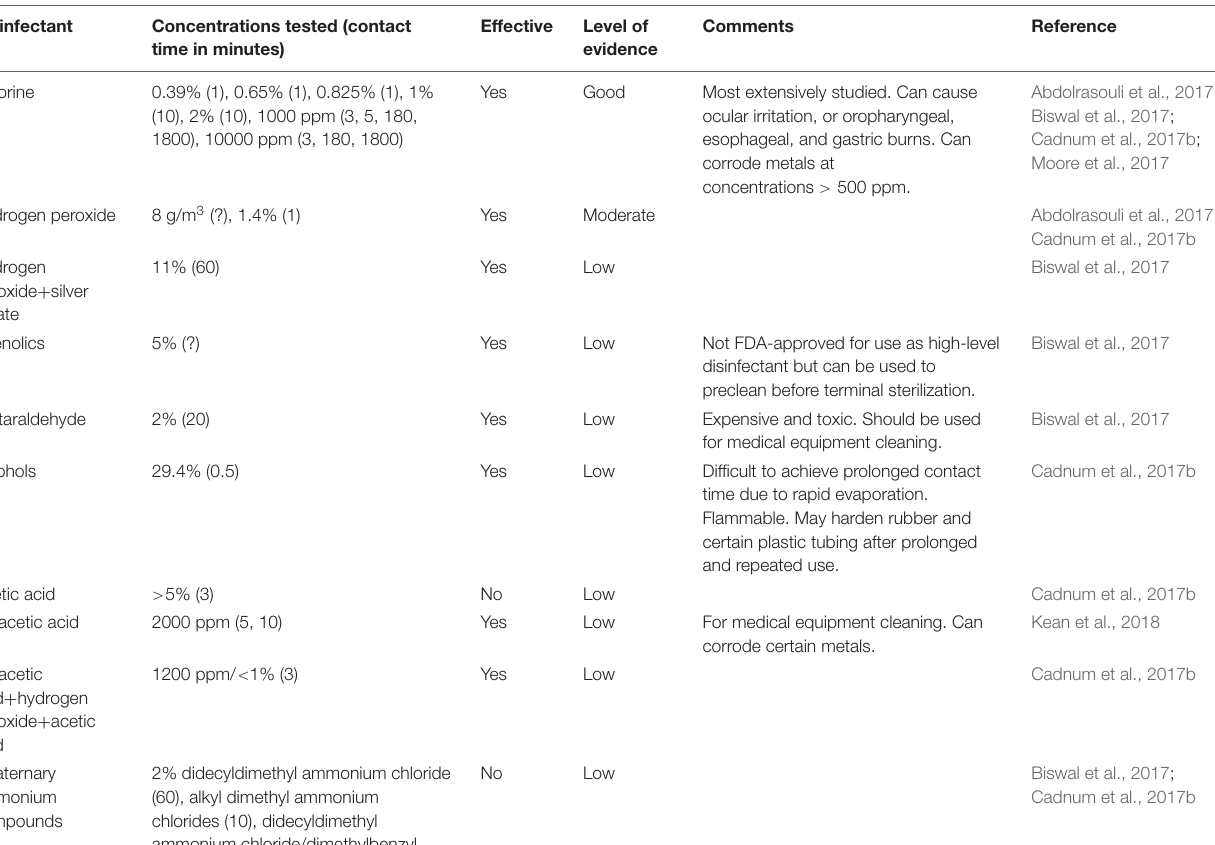
TABLE 2 | Surface disinfectants tested against C. auris